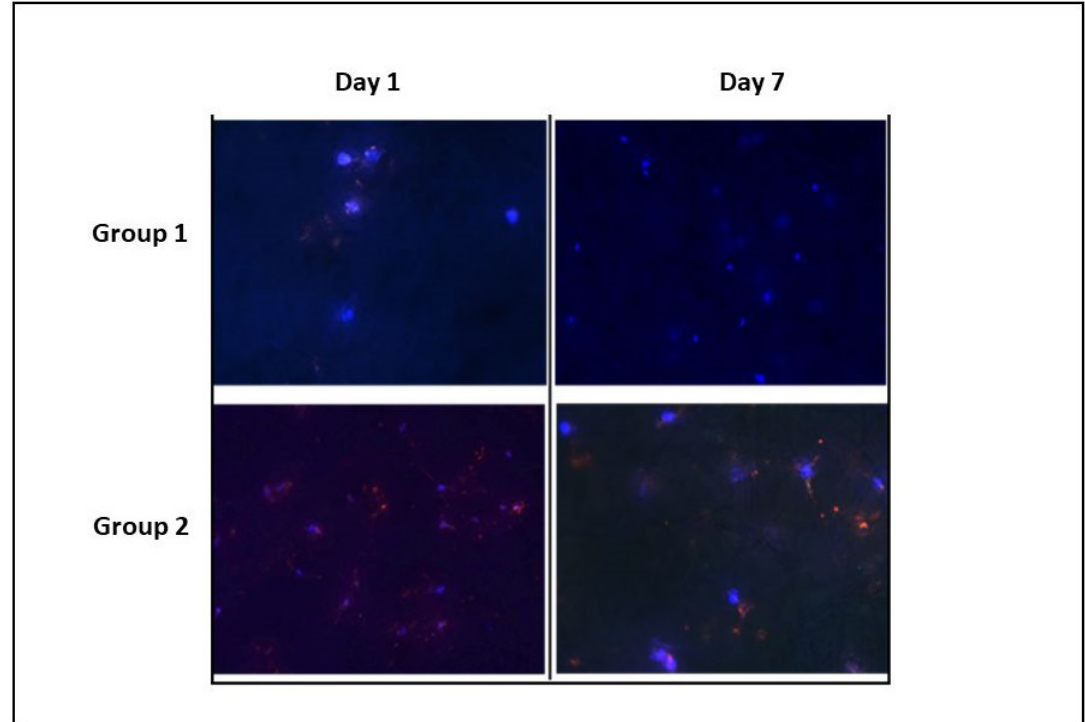
and Group 2 – Nanotubes of TiO 2